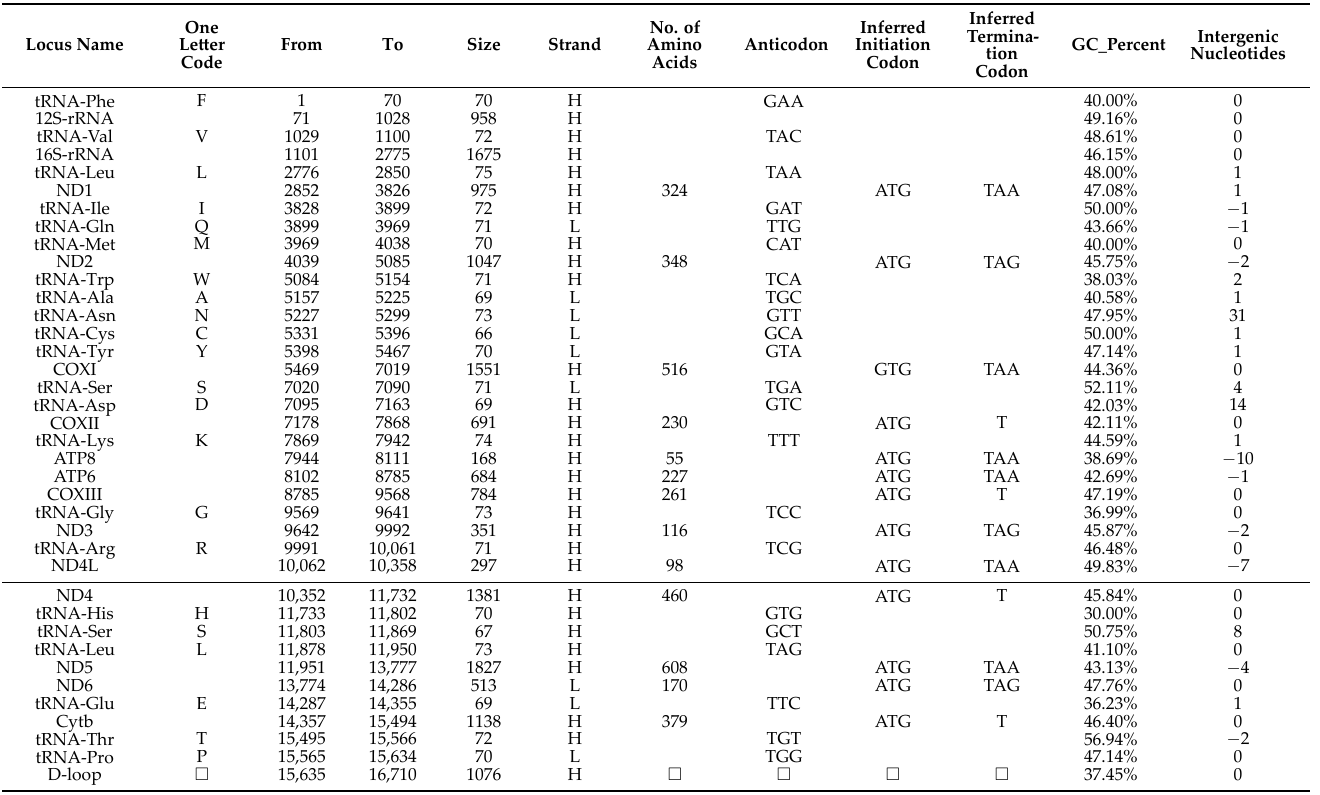
Table 1. Sequence characteristics of Arius maculatus mitochondrial